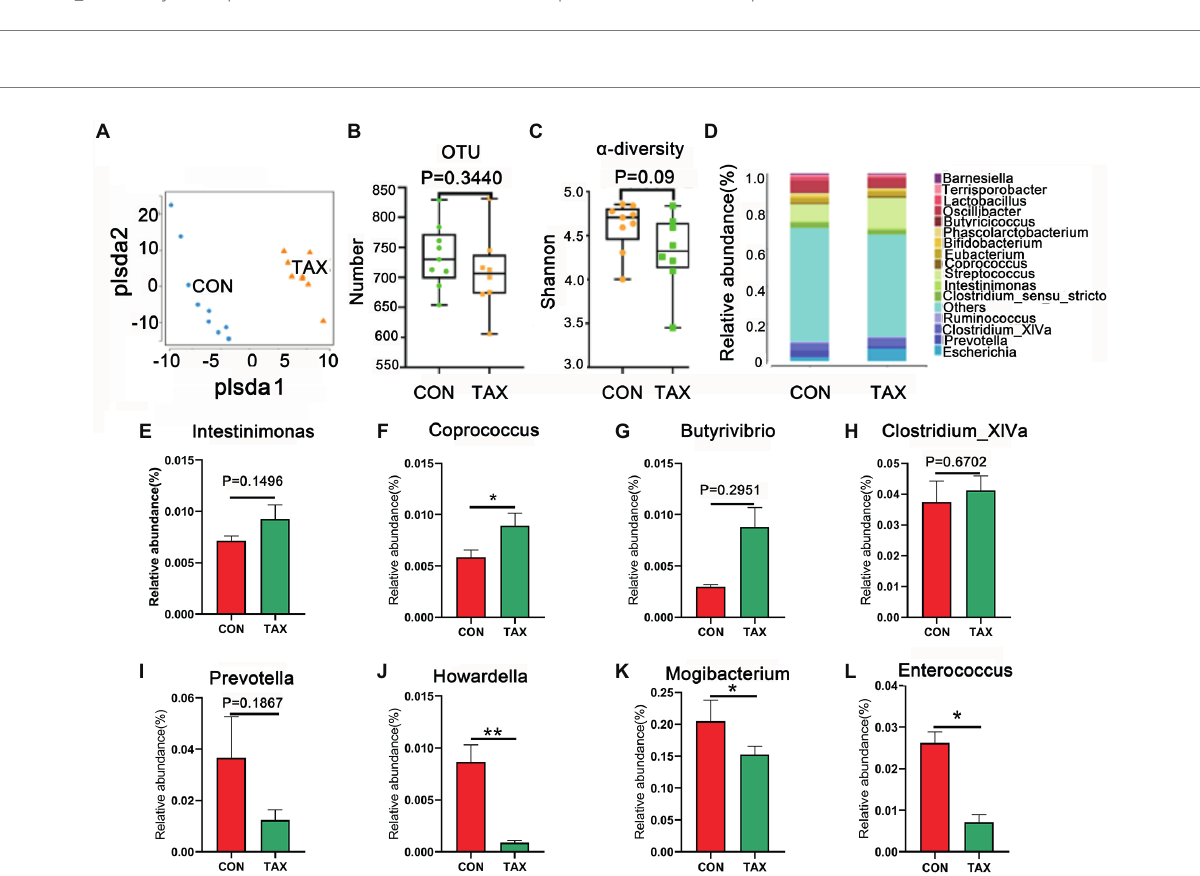
FIGURE 5 Effects of TAX on the fecal microbial composition. (A) The PLS-DA analysis of OUT of fecal microbes. (B) The levels of OUTs. (C) α -diversity with Shannon. (D) The relative amount of microbiota in feces at the genus level. The relative amount of individual microbiota in feces at the genus level (E–L) . Data were expressed as the mean ± SEM. * p < 0.05. ** p <